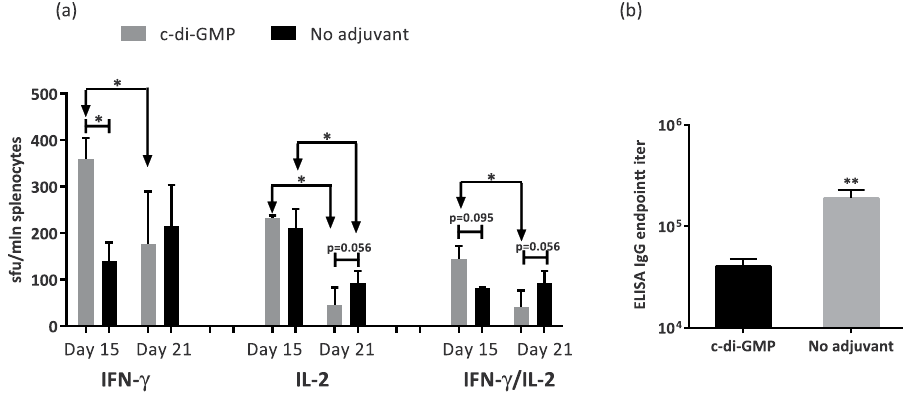
Figure 7. The effect of c-di-GMP adjuvant on the specific IFN- γ /IL-2 immune response in mice immunized with RT genes. BALB/c mice (n = 5) were immunized on days 1 and 5 with two intradermal injections of 20 µ g RTwt-opt-in encoding plasmid per mouse (standard protocol with EP) followed by intraperitoneal injections of 1 nmol c-di-GMP (“c-di-GMP” group) or PBS (“No adjuvant” group), and control mice were similarly treated with the empty vector pVax1. On day 15, mice were bled and their PBMCs were collected and stimulated with peptide representing the immunodominant epitope of RT (RT528–543; Table 2). Cytokine production in response to stimulation was assessed by IFN- γ /IL-2 Fluorospot ( a ) On day 21, mice were sacrificed and their splenocytes were collected and subjected to the same IFN- γ /IL-2 test. ( a ) The results represent the average number of cells, registered as signal-forming units (sfu) per million splenocytes secreting IFN- γ , IL-2, and IFN- γ /IL-2, and the error bars represent the SD. ( b ) Endpoint (day 21) titers of anti-RT total IgG detected in ELISAs against recombinant RTwt protein with cut-offs set against the serum reactivity of control mice immunized with the vector pVax1. All assays were performed in duplicate. * p < 0.05; p-values in the interval 0.05 to 0.1 indicate tendencies. Statistical comparisons were performed using Mann–Whitney